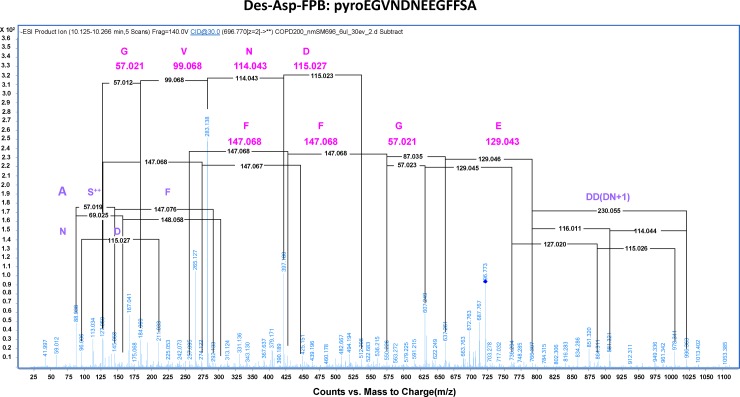
MS/MS fragmentation of a doubly-charged ion ([M+2H] = 697.97 Da) reveals the sequence of peptide as pyroEGVNDNEEGFFSA.Fragments derived from ion fragmentation at 30 EV match the amino acid sequence of fibrinogen peptide B with truncated C-terminal arginine and N-terminal amino acid modified as pyroglutamate.